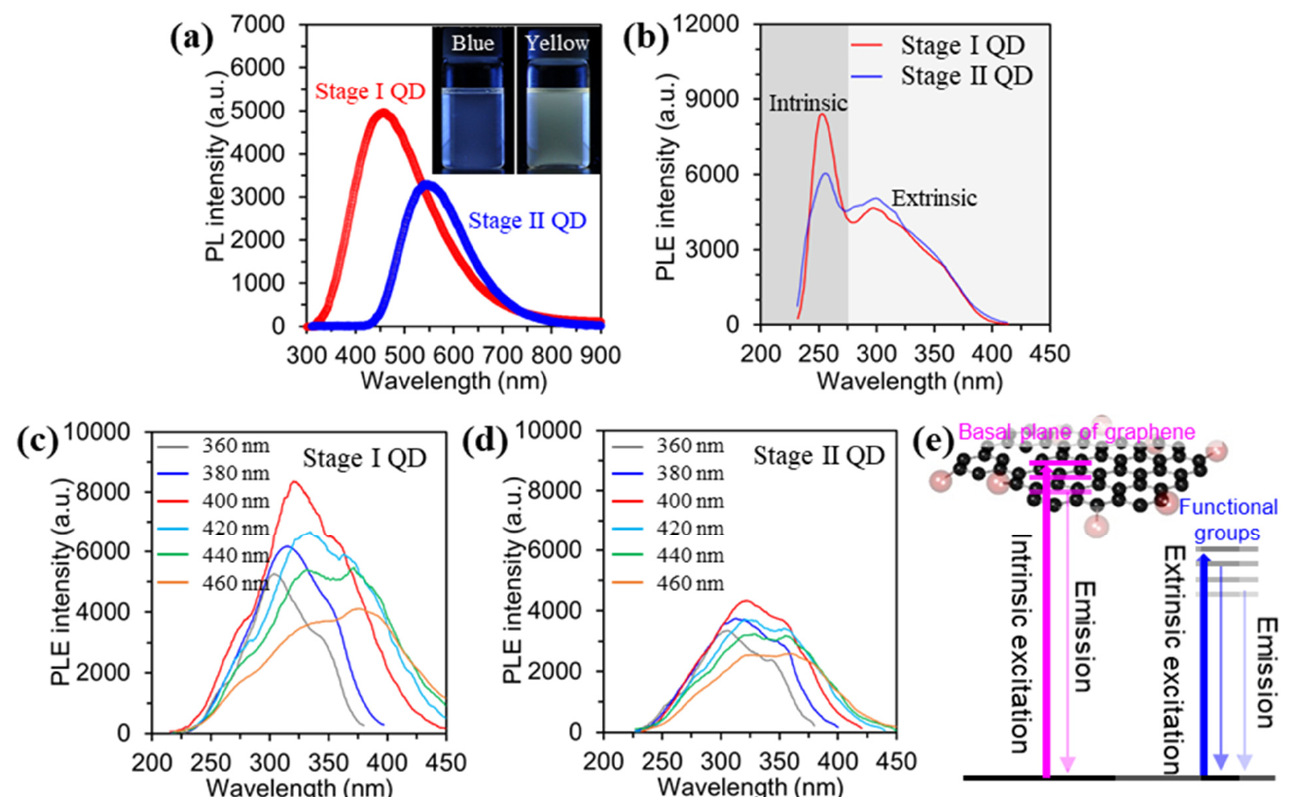
Figure 4. Optical characterizations for the stage I and stage II GQDs. ( a ), PL spectra of the GQDs under excitation at 310 nm. Digital images of the GQDs before and after emission under excitation of λ = 365 nm (Inset). ( b ), PLE spectra of the GQDs. ( c , d ), PLE spectra of the GQDs with varying